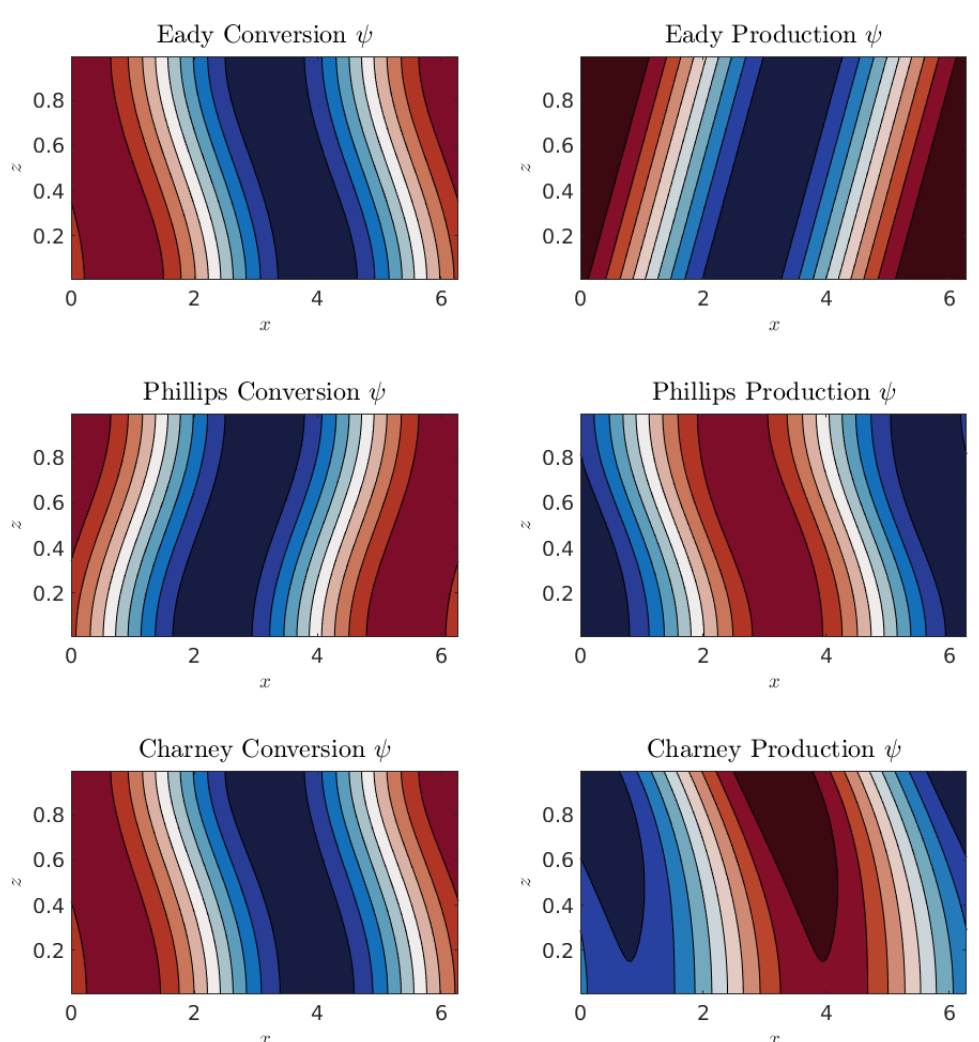
Figure 3. Flow configurations ψ that locally optimize the rate of conversion ( left ) and production ( right ) per unit energy for the Eady ( upper row), Phillips ( middle row), and Ocean Charney ( lower row) mean flow configurations. In all panels, ψ has been normalized to amplitude 1, and the contours are from − 1 to 1 in increments of 0.2. The horizontal coordinate x has been nondimensionalized using NH / f